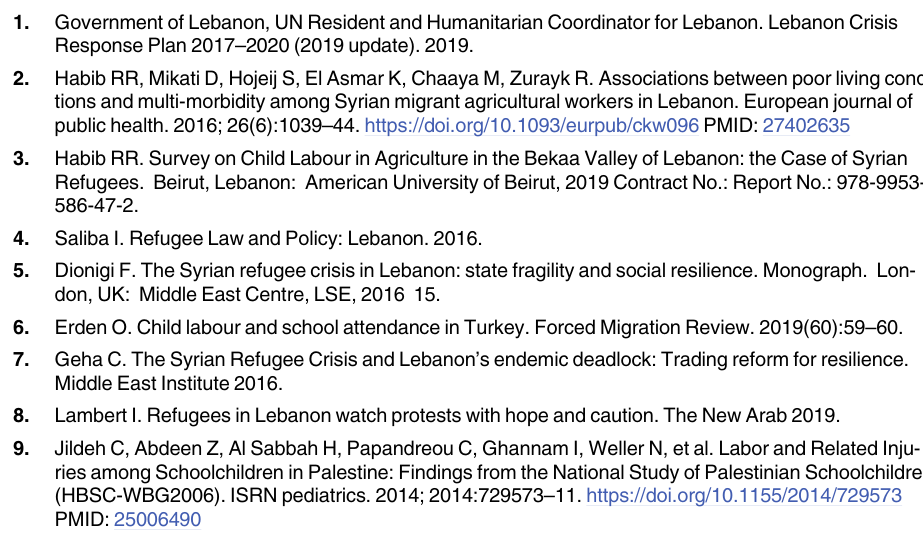
S1 Table. Associations between sociodemographic, work characteristics and work-related injuries among male Syrian refugee working children (8–18 years) in the Bekaa Valley, Lebanon, 2017 (N = 2107). S2 Table. Associations between sociodemographic, work characteristics and work-related injuries among female Syrian refugee working children (8–18 years) in the Bekaa Valley, Lebanon, 2017 (N =